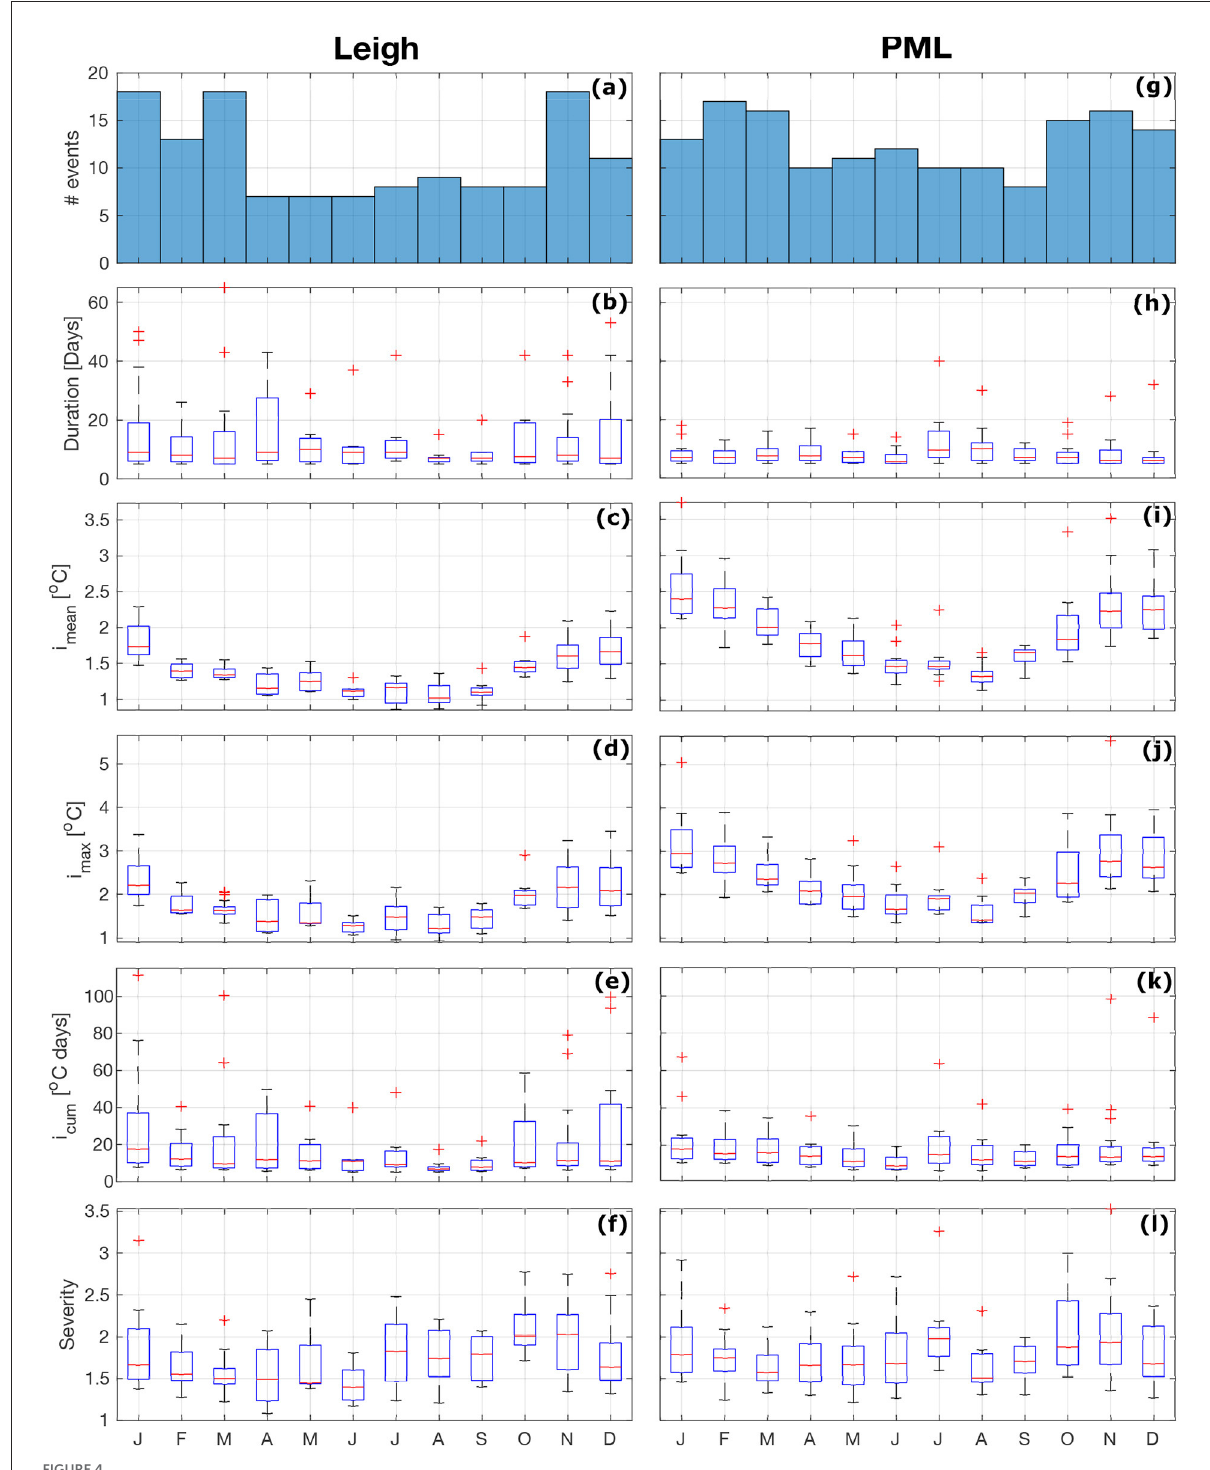
FIGURE4 MHW metrics from detected events at Leigh (a–f) and PML (g–l) sorted by month. (a,g) Are histograms of event numbers for each month with box plots (b–f,h–l) of event duration, intensities (mean, maximum, and cumulative) and severity also displayed. Seasonality in mean (c,i) and maximum (d,j) intensity is observed but no clear patterns are observed for duration (b,h) , cumulative intensity (e,k) , and severity (f,l)